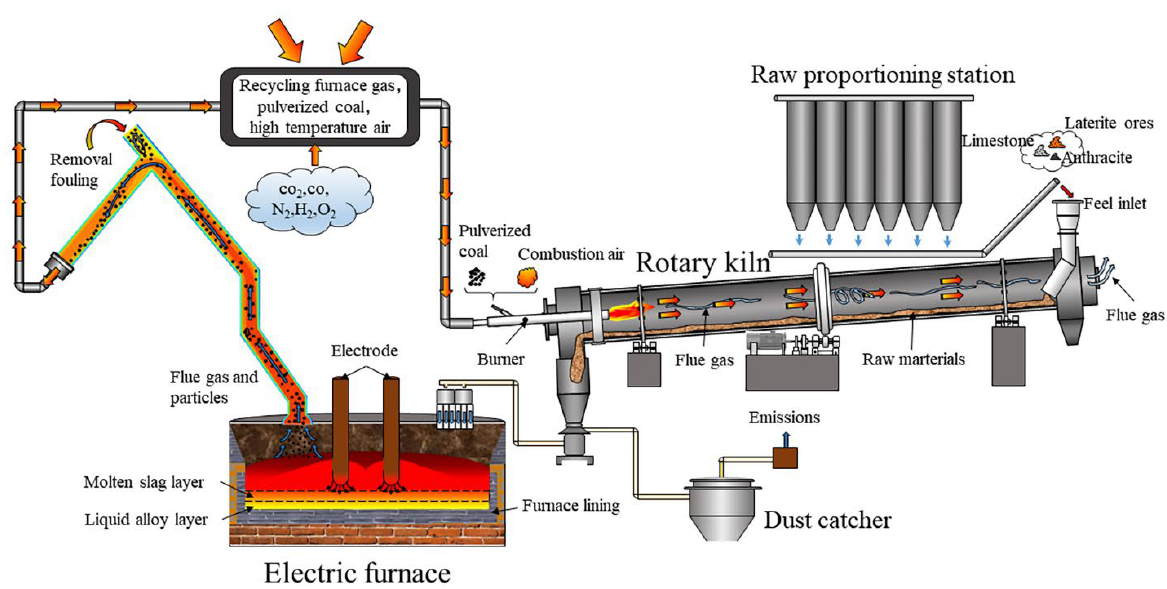
Figure 1. RKEF process flow diagram.